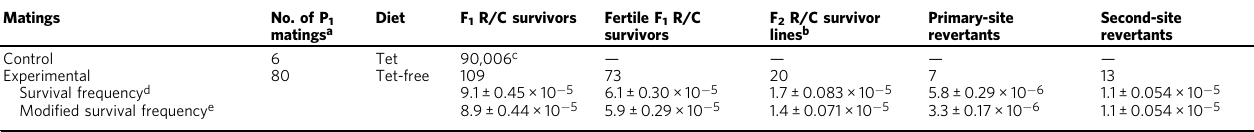
Table 1 Tet-off lethality revertant adult survivors on Tet-free diet. Matings